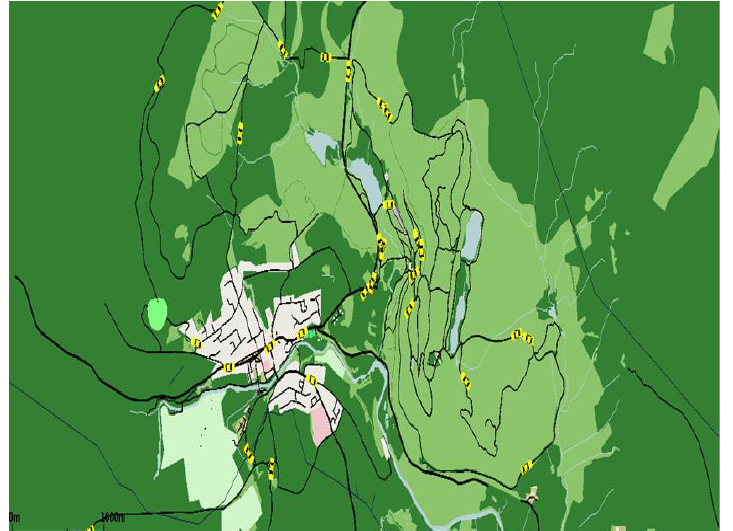
Figure 6 . Open Street map in